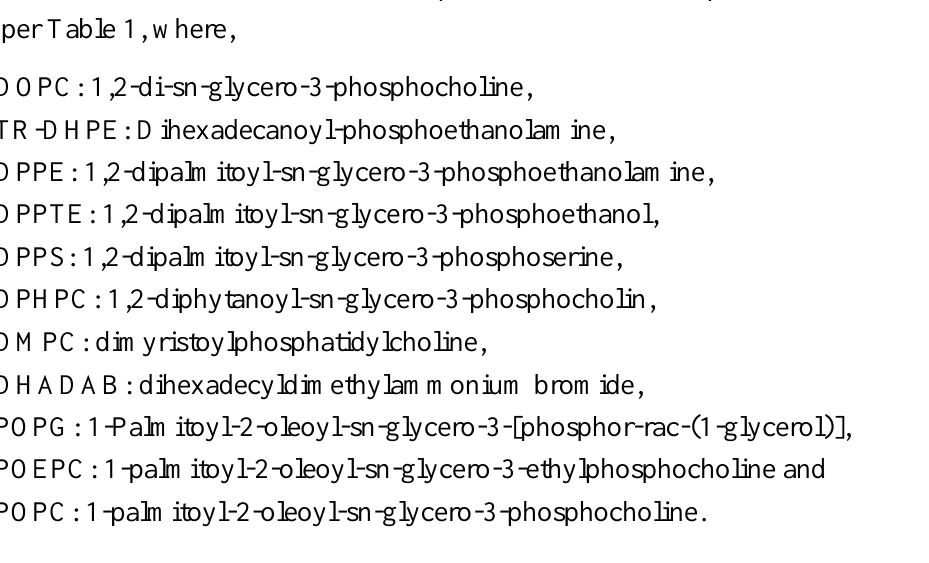
Table 1. Membrane’s capacitance and resistance using EIS published in recent years. Reference Supporting